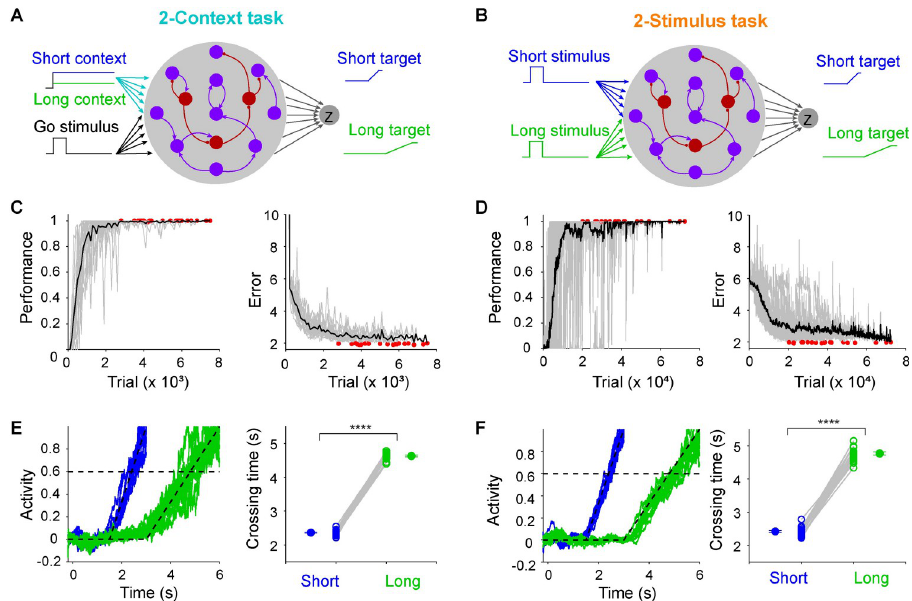
Fig 1. RNNs were trained on one of two timing tasks, both of which required producing the same timed output patterns. ( A ) Schematic of the 2-Context task. Each RNN was composed of 200 units—80% excitatory units (purple) and 20% inhibitory units (dark red)—and received a go and a context input. The context level signals the interval length to be produced: high = short (3 s, blue), low = long (6 s, green). ( B ) Schematic of the 2-Stimulus task. The same RNN was used in both tasks, except that the short- and long-interval was cued by two different inputs that were transiently activated. ( C ) Learning curve for the performance of 20 RNNs trained on the 2-Context task. Percentage of trials in which the timing of the output unit met criteria (left) and the error between the output and target (right). Gray traces represent results of each RNN, red dots denote the end of training for a given RNN, and the black trace represents the mean performance. ( D ) Same as in ( C ) but for the 2-Stimulus task. ( E ) Output traces across ten short (blue) and long (green) trials from an RNN trained on 2-Context task (left). Mean crossing times for long interval is significantly higher than that for short interval (right, n = 20 simulations, paired t test, t 19 = 77.70, P < 0.0001). Dashed lines denote the targets and threshold. ( F ) Same as ( E ) but for 2-Stimulus task ( n = 20 simulations, paired t test, t 45.79, P <